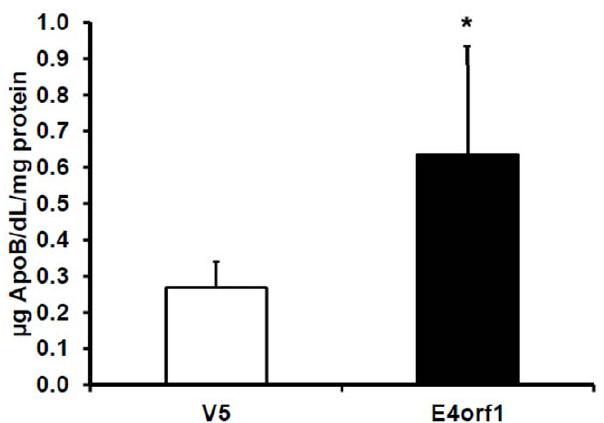
Figure 6. ApoB Secretion from HepG2 Transfected with E4orf1. ApoB secretion in conditioned media from HepG2 transfected with E4orf1 or null vector. Expressed as mean m g ApoB/dL/mg protein, 6 SD. Ad36 E4orf1 increased ApoB secretion into media compared to the null vector (V5) (p=0.01).